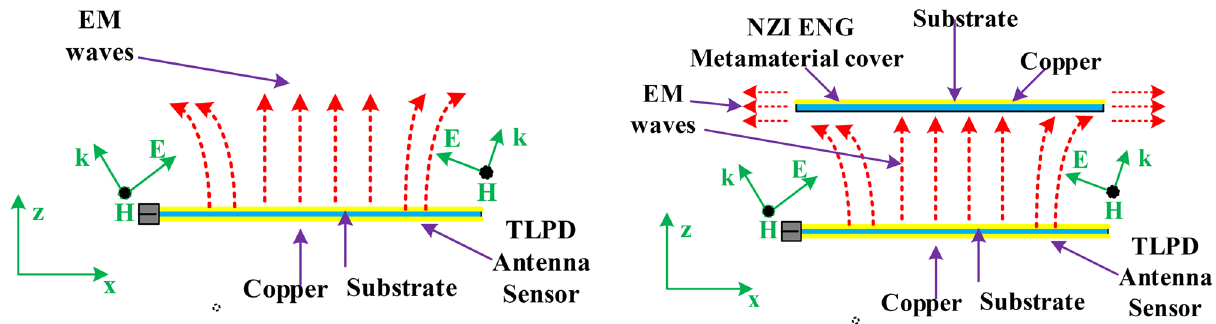
Figure 33. TLPD Antenna gain enhancement mechanism ( a ) Without NZI MTM Cover ( b ) With NZI MTM